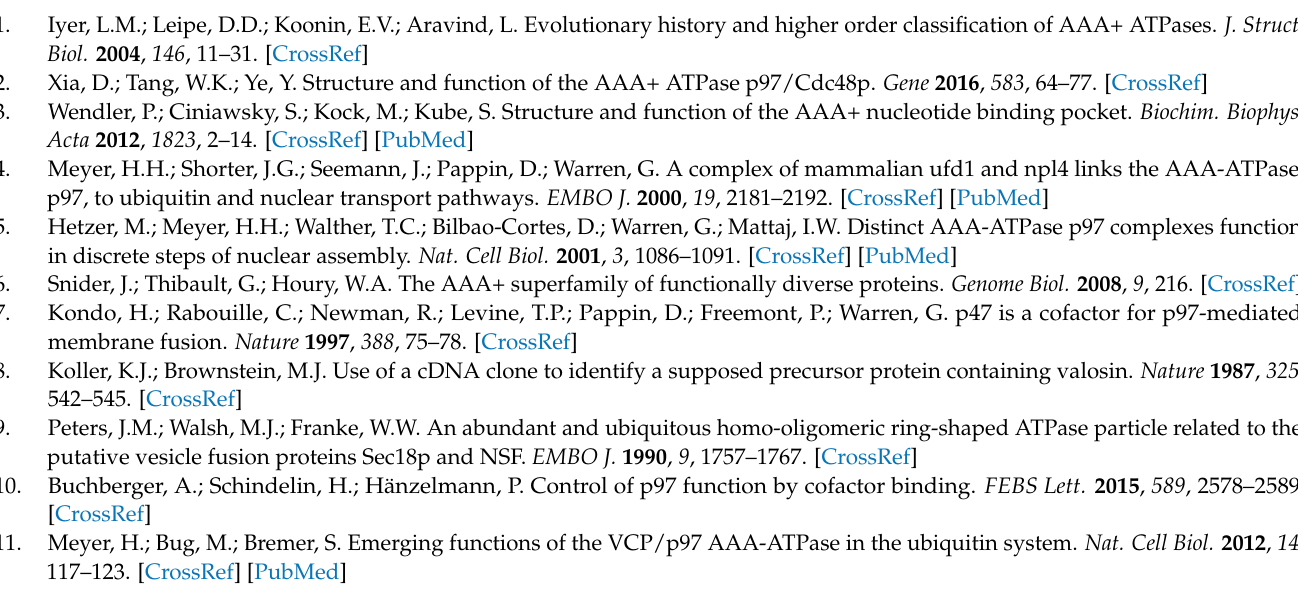
Figure S4: Biochemical characterization of the p97R155H|ADP-p47 and p97R155H|ATP γ S-p47. Figure S5: Cryo-EM structural analysis of the full-length p97R155H|ADP-p47 assembly. Figure S6: Cryo-EM structural analysis of the full-length p97R155H|ATP γ S-p47 assembly. Figure S7: Modelling of atomic coordinates into the cryo-EM densities of p97R155H|ATP γ S-p47 complexes. Figure S8: Cryo-EM structure of the p97R155H|ADP-p47 complex. Figure S9: Deep coordinate neural network analysis of the p97R155H|ADP-p47 single-particle cryo-EM images. Figure S10: Western blotting analyses of the SEC-eluted fractions of the p97-p47 complexes. Figure S11: Determination of the binding constant, K d , for the interaction between p97 arginine finger mutants and p47 proteins. Table S1: List of plasmids used for overexpression of p97 and p47 proteins. Table S2: Statistics of single-particle cryo-EM structure determination on p97-p47